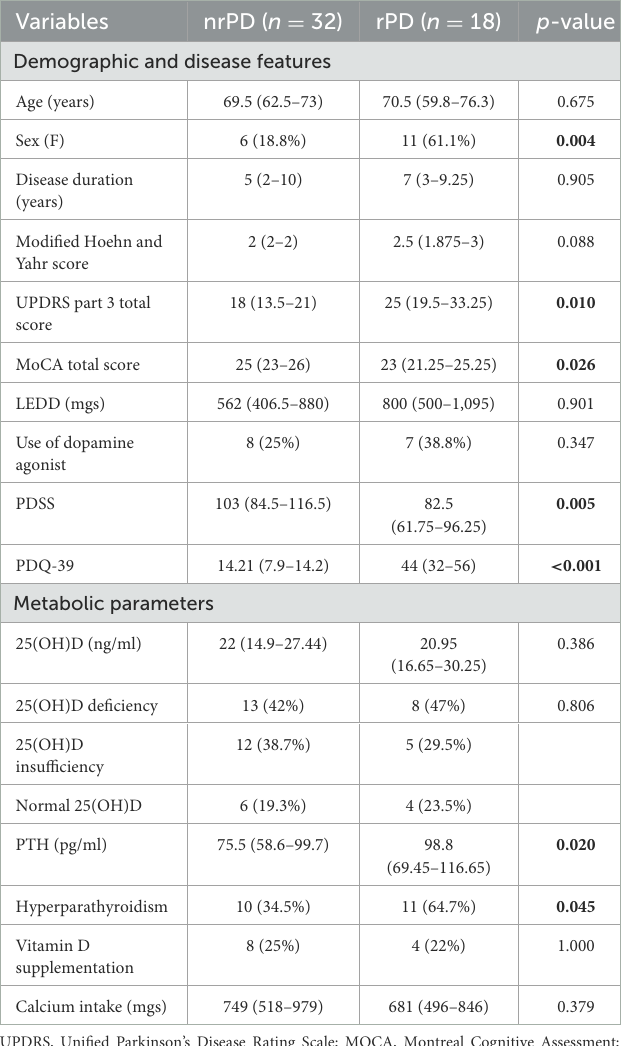
TABLE 2 Demographic data, disease features, vitamin D (25(OH)D), and PTH-related parameters distributed according to leg restlessness.